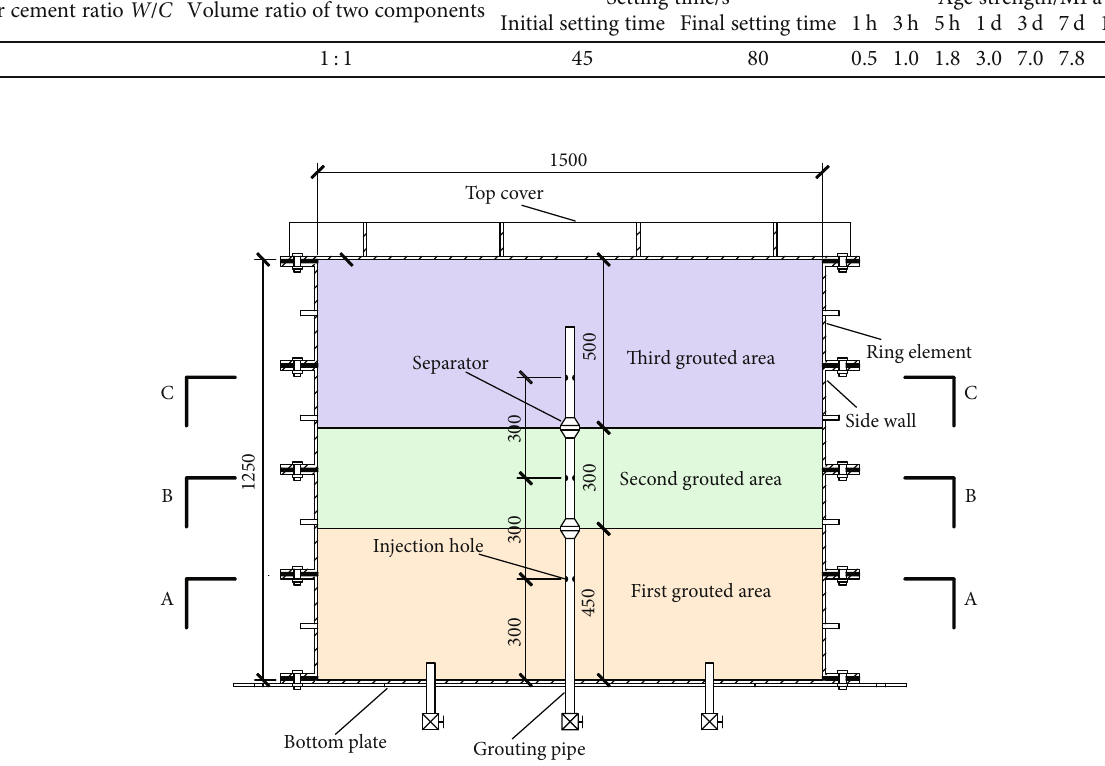
Figure 6: Design of segmental grouting operation (unit: